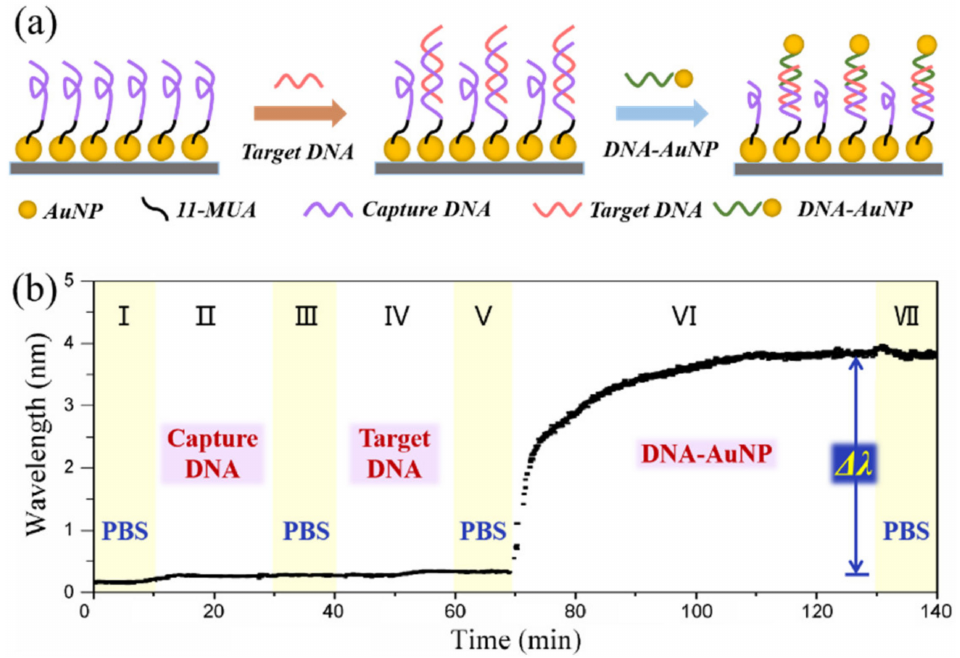
Figure 6. AuNP-enhanced LSPR biosensing of ssDNA hybridization of the LSPR biosensor. ( a ) Schematic diagram of hybridization process. ( b ) Wavelength responses and calibration binding curve for ssDNA